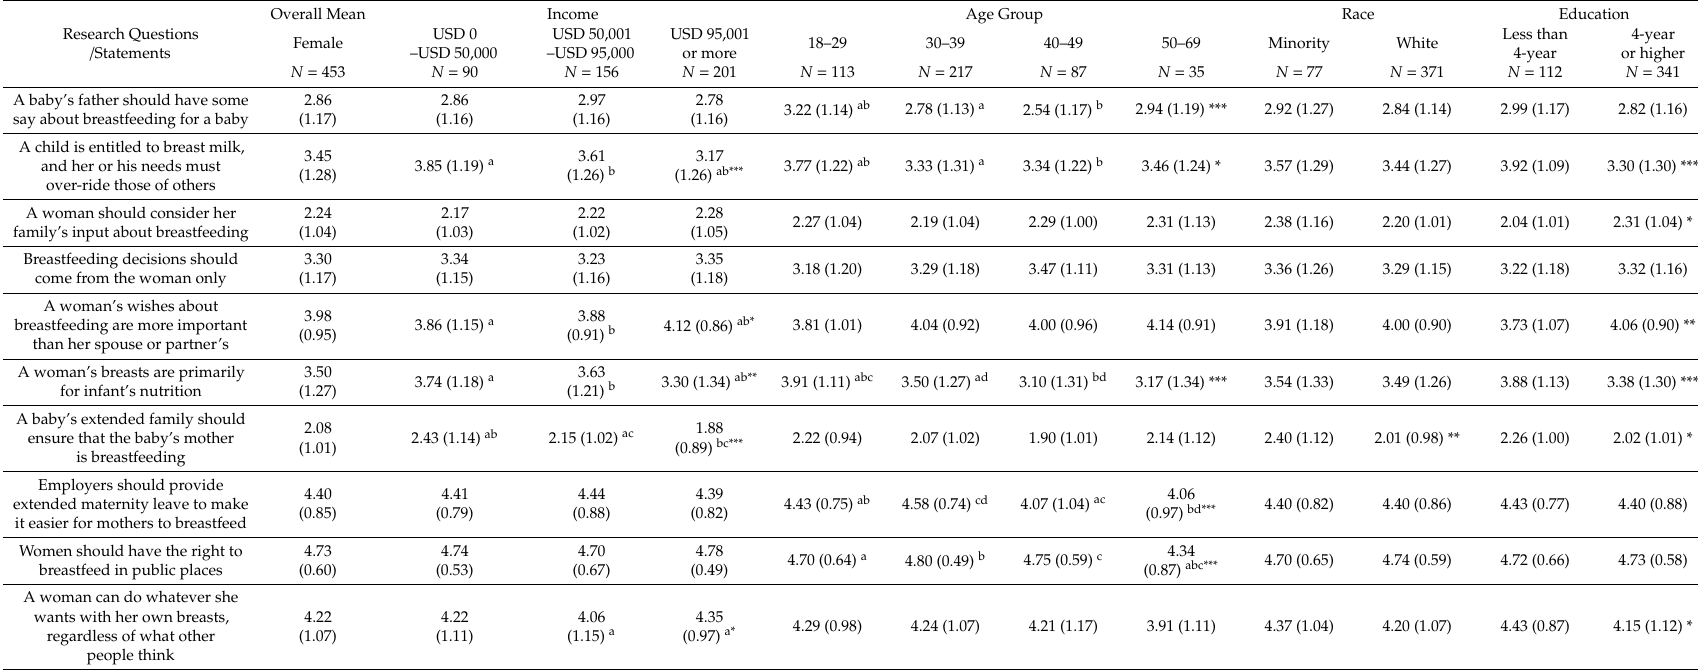
Table 2. Breastfeeding perceptions by demographic groups (1 = Strongly disagree to 5 = Strongly